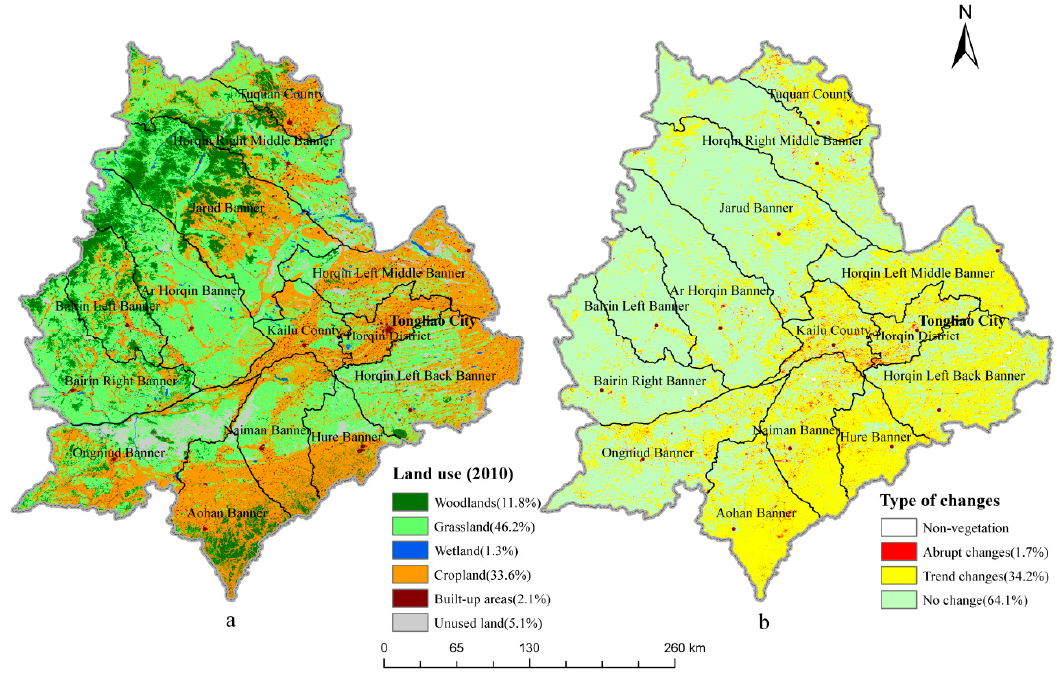
Figure 5. Land use in 2010 ( a ); and land cover changes in study area ( b ). Table 3. Area of trend land cover changes with different change rates related to land cover types.